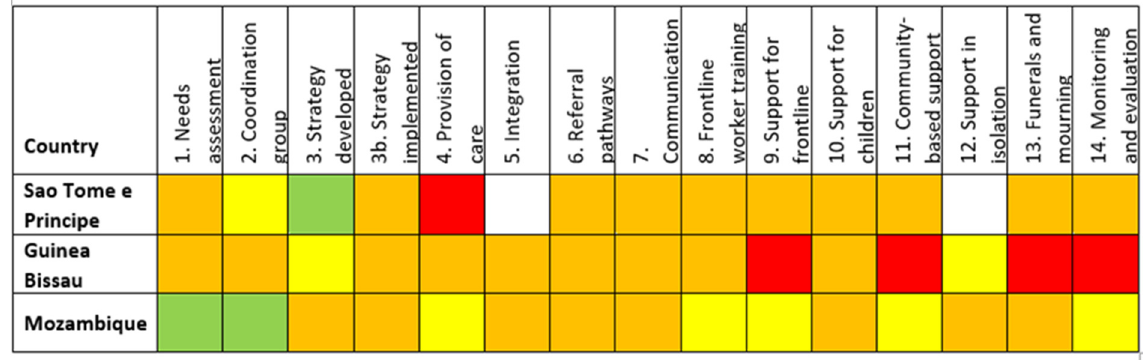
Figure 3. Lusophone countries’ responses to survey based on IASC 14 recommended MHPSS activities in the COVID-19 outbreak.